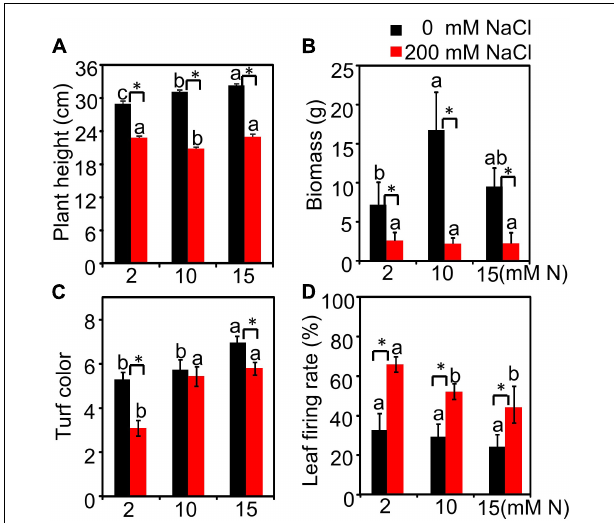
FIGURE 1 | Morphological parameters of bermudagrass grown under different treatments. The plants were cut to the same height and then transferred into different nitrogen levels (2, 10, and 15 mM) under NaCl (0 and 200 mM) treatment in hydroponic culture. After treatment, the plant height (A) , biomass (B) , leaf color (C) , and firing rate (D) were measured. Different letters above the columns indicate statistically significant differences at P < 0.05 under different N levels with the same NaCl level by Tukey’s test. ∗ Shows significant differences ( P < 0.05) under 200 mM NaCl treatment and 0 mM NaCl condition with the same N level by Tukey’s